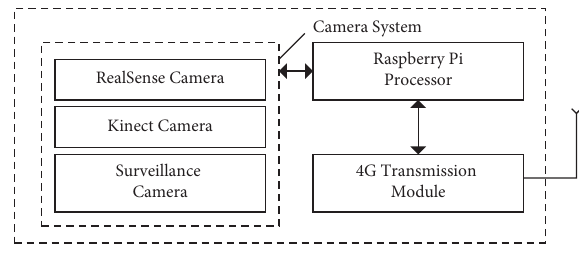
Figure 8: Block diagram of the image acquisition system.